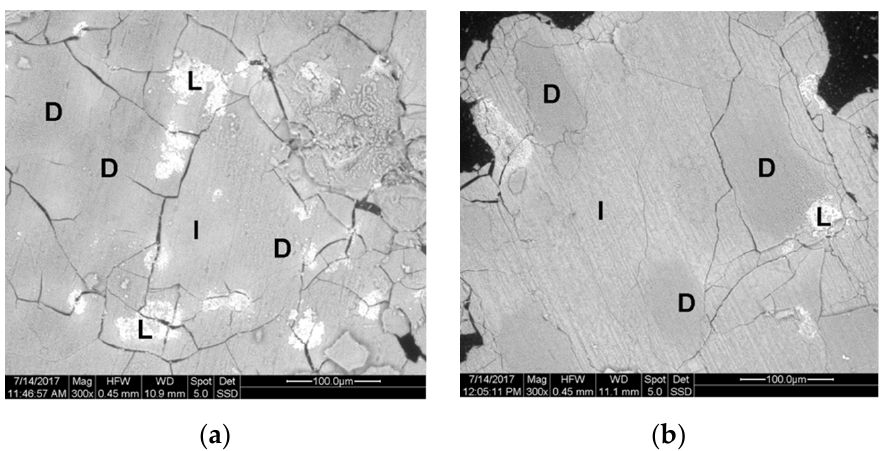
Figure 6. SEM backscattered electron images ( × 300) of TB electrochemical patinas samples (internal